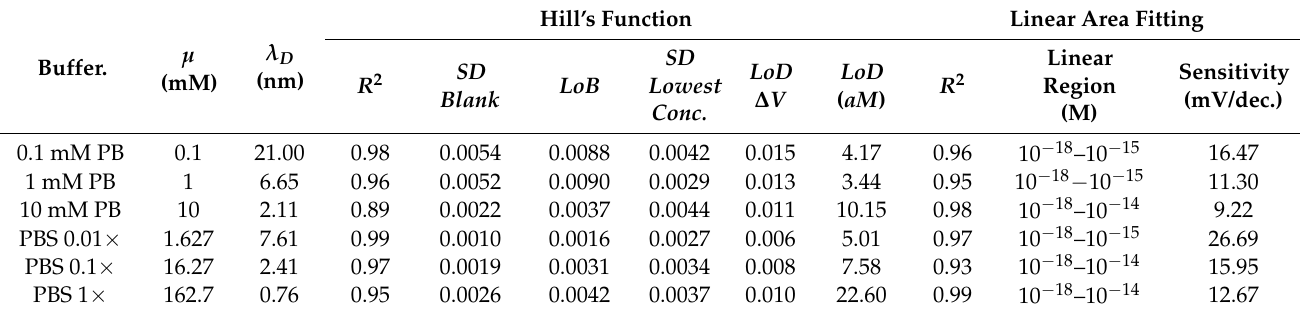
Table 1. Analytical parameters of DNA detection on GFET sensor with different background buffers.